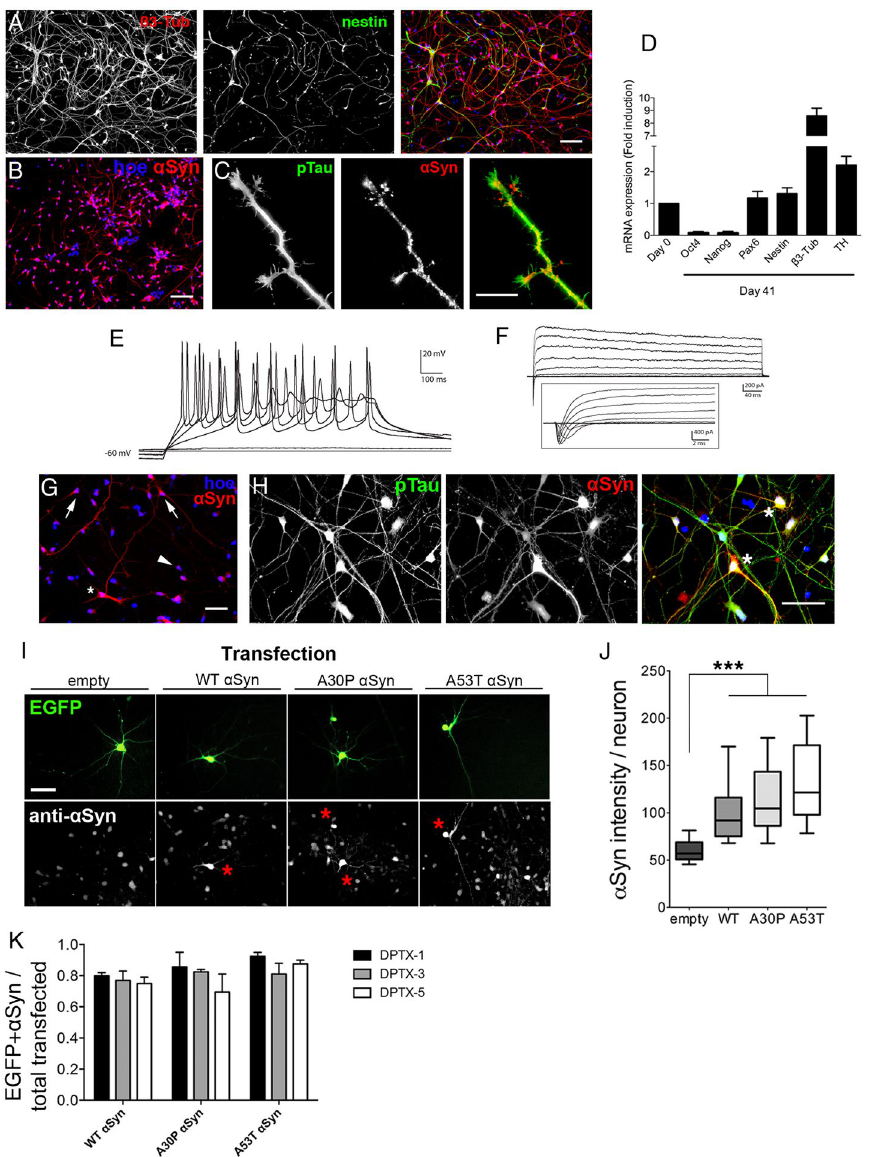
Figure 1. α Syn overexpression in functional hESC-derived neurons. ( A – F ) Human neuronal culture characterization. ( A ) High expression of the neuronal marker, β 3-tubulin, and low expression of the precursor marker, nestin (Scale bar, 100 μ m). ( B ) Endogenous α Syn cytosolic localization. Nuclei stained with Hoechst (blue). Scale bar, 100 μ m. ( C ) α Syn localization is enriched within neuronal processes (p-Tau). Scale bar, 20 μ m. ( D ) qPCR quantification at day 41 of the differentiation protocol showing mRNA expression for stemness (Oct4, Nanog), neural markers (Pax6, Nestin), and specific neuronal markers (Tuj1, TH) relative to undifferentiated hESC (mean ± SEM, n = 4 independent experiments). ( E ) Representative traces of spiking evoked by stepwise increases of current from 0 to 40 pA, incremented by 10 pA. Cells were kept at − 60 mV in current clamp. ( F ) Representative traces of Na + and K + voltage-dependent currents evoked by depolarizing voltage steps, incremented every 10 mV. Cells were voltage clamped at − 70 mV. Inset shows higher temporal resolution. ( G – J ). Human neurons overexpressing α Syn. ( G ) α Syn immunofluorescent staining in transfected neurons (asterisk), non-transfected neurons (arrows), and non- α Syn-expressing cells (arrowhead) at DIV14 cultures. Scale bar, 50 μ m. ( H ) Neurons (p-tau) transfected with α Syn display increased levels of expression by immunofluorescence. Scale bar, 50 μ m. ( I and J ) α Syn immunofluorescent staining in neurons co-transfected with EGFP and control (empty), WT, A30P, or A53T α Syn (asterisks). Scale bar, 50 μ m. Intensity measurements of α Syn staining in the different conditions. Data represented as median plus interquartile range. Kruskal- Wallis ANOVA (p < 0.05). (n = 80 neurons per condition from 2 independent experiments). ( K ) Average cell ratio performed to identify neuron survival upon α Syn expression in 1, 3 and 5 days post-transfection (DPTX). Ratio obtained by dividing α Syn positive neurons (overexpressing above threshold in Fig. S3C) by total EGFP + neurons (above and below α Syn threshold) (n = 20 images per condition, more than 5 neurons by field from 2 independent experiments). See also Figures S1, S2 and